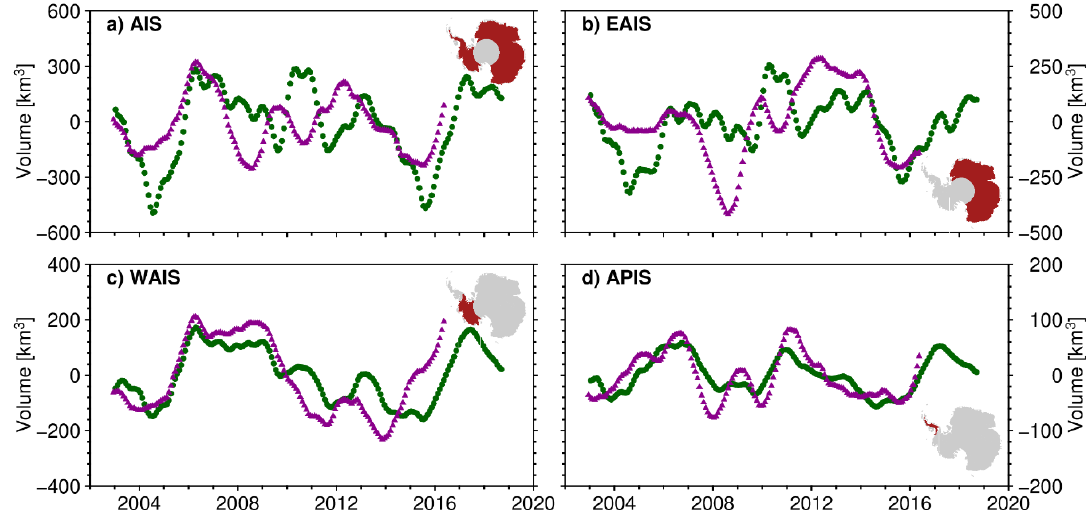
Figure 8. Volume change of the AIS north of 81.5° S ( a ) and the three subregions (( b ): EAIS, ( c ): WAIS, and ( d ): APIS) from our combined altimetric time series (green dots) and IMAU-FDM (purple triangles). After removing the long-term trends, seasonal oscillations were removed using a 13-month moving average. Due to the defects of the moving average algorithm, the 6-month values at the beginning and end of the time series are not displayed. The regions covered by each localization are shaded red in the inset. The boundaries refer to the Antarctic drainage systems in [47] .